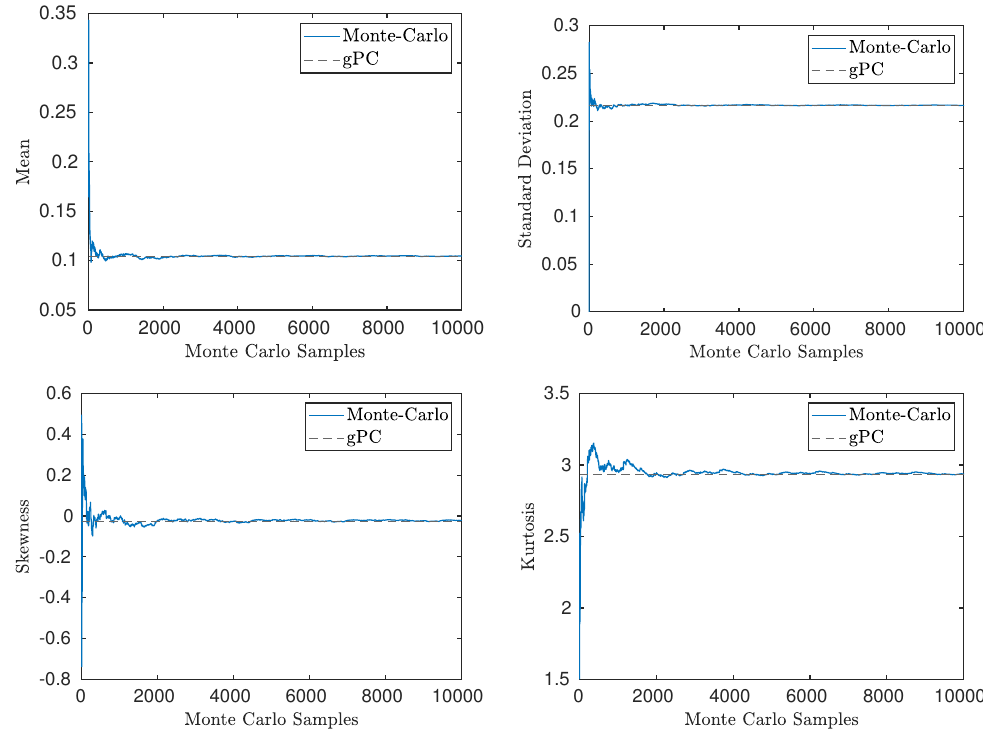
Figure 7. UQ in the sensitivity of the QoI given by Equation (32) with respect to F . Comparison of statistical moments, as computed by Monte–Carlo coupled with Finite-Differences and gPC ( c = 4) coupled with the MSS algorithm. Uncertainty is introduced through F = 10 + 0.3 ξ where ξ ∼ N ( 0,1 ) . Here, N = 40 and T = 100.